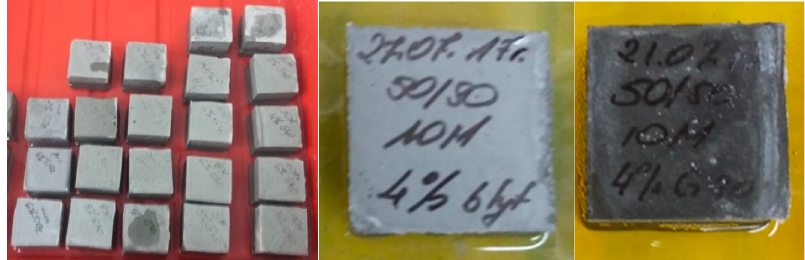
Figure 8. Appearance of selected samples during tests for tendency to efflorescence (after 60 days), samples cured in water.